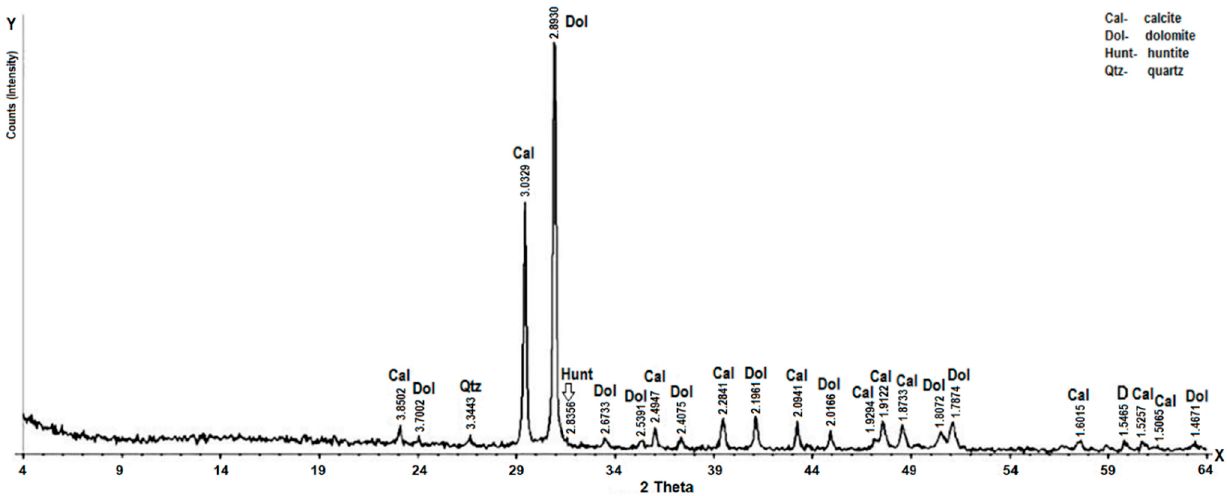
Figure 5. Diffractogram of sample SO14, limestone of the Karchowice Unit taken in the Strzelce Opolskie Quarry [24].